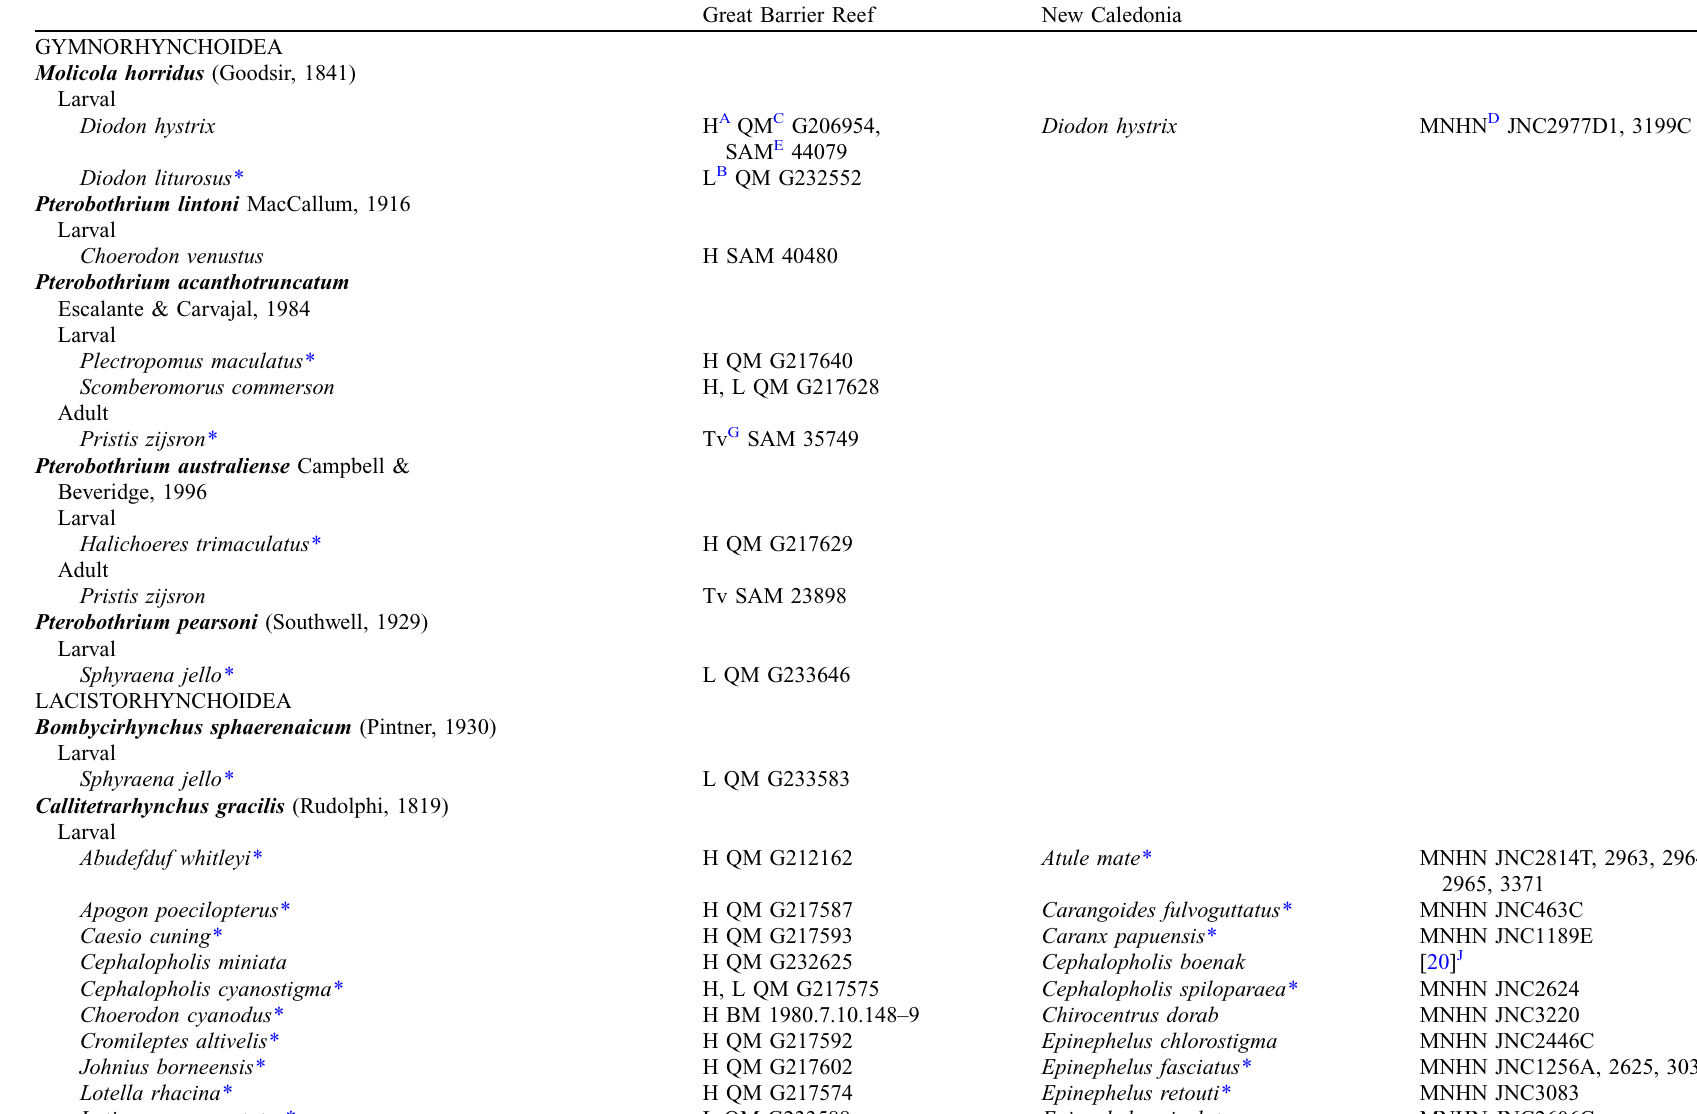
Table 1. Parasite-host list. Species of trypanorhynch cestodes collected from teleosts and elasmobranchs on the Great Barrier Reef, Australia and from New Caledonia. Authorities of cestodes are included and host species are listed in alphabetical order without